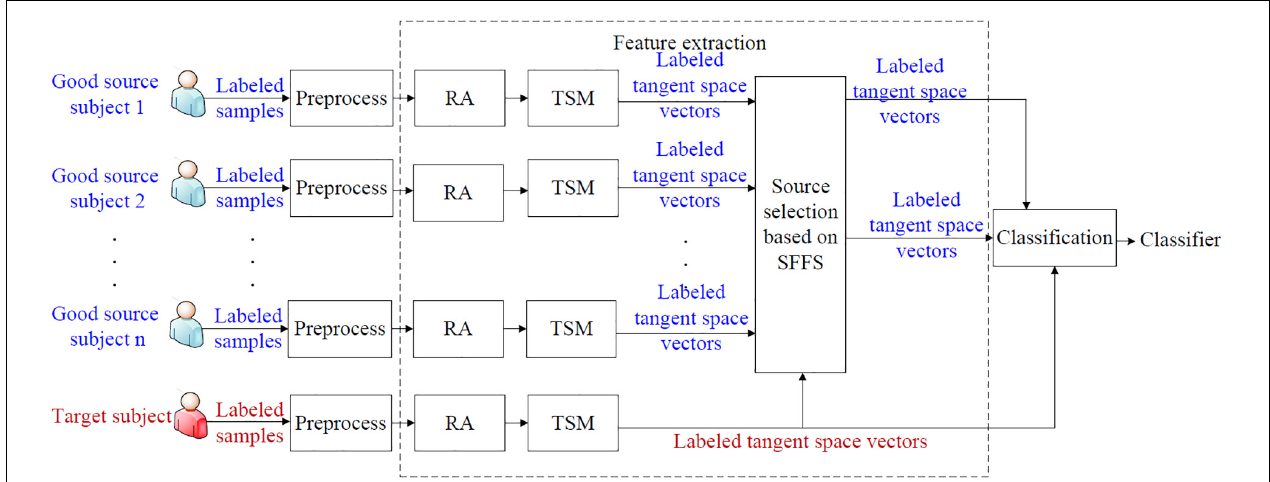
FIGURE 1 | The framework of supervised selective cross-subject transfer learning